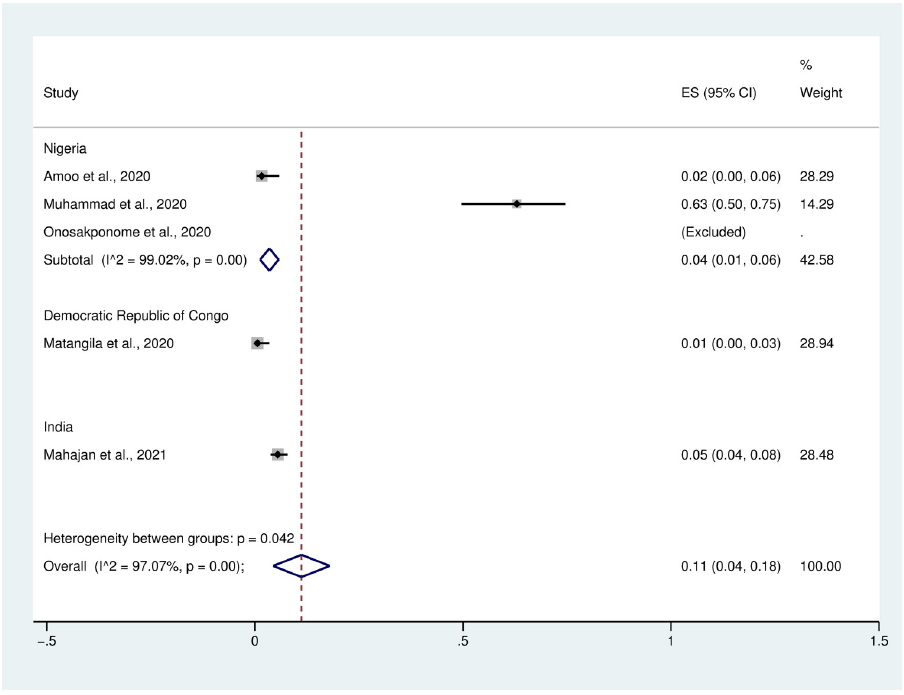
Fig 3. Forest plot of the pooled prevalence of Plasmodium spp. infection among patients with COVID-19. ES, effect size; CI, confidence